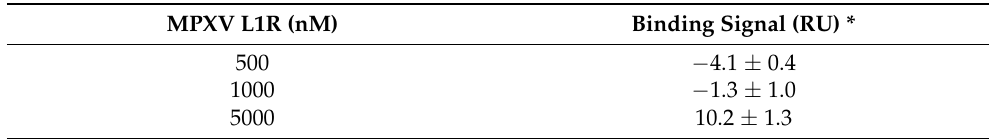
Table 1. The binding affinity of MPXV L1R–heparin